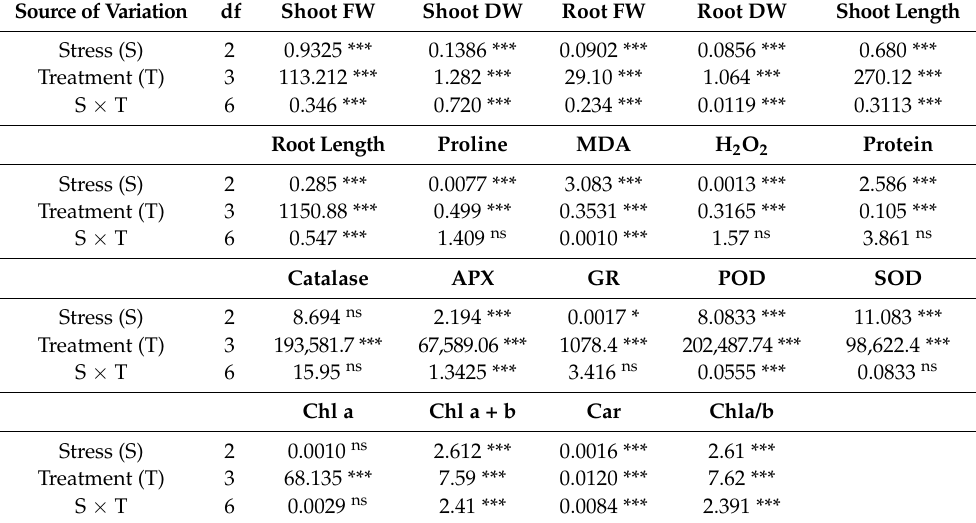
Table 3. Mean Squares from two way analysis of variance data for different morphological and biochemical indicators of Maize ( Zea mays L.) treated with Bacillus subtilis under chromium stress. Source of Variation